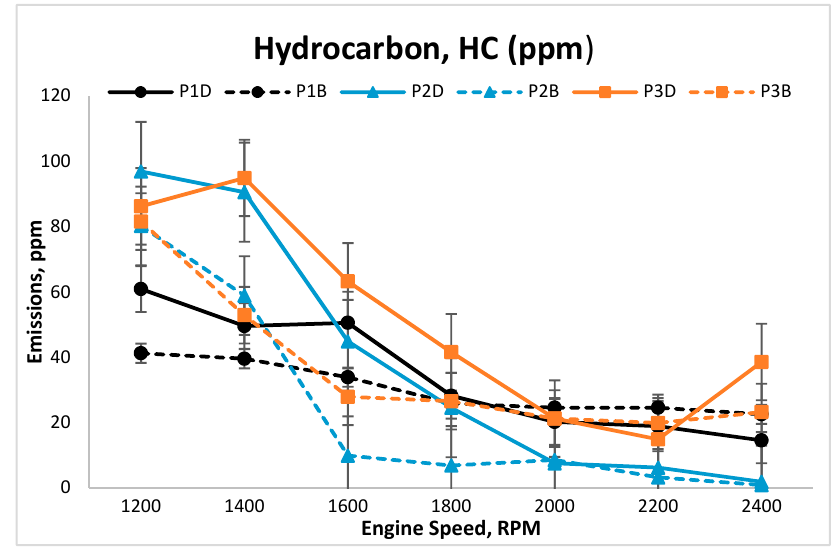
Figure 8. Hydrocarbon emissions at the variable engine speeds.